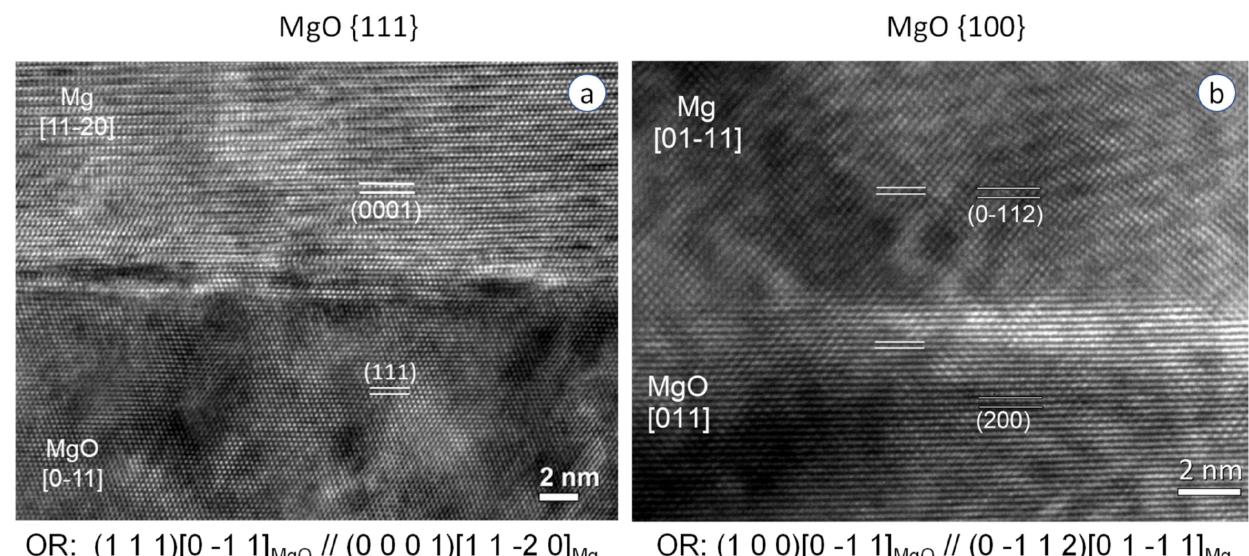
Figure 14. Experimental validation of lattice twist in systems with positive misfit [70]. Experimental evidence for no lattice twist after heterogeneous nucleation in systems with positive misfit. High resolution TEM images showing nucleation of α -Mg on {111} terminated MgO ( a ) and {001} terminated MgO ( b ) suggesting that there is no twist between the solid and the substrate. In both cases the lattice misfit is